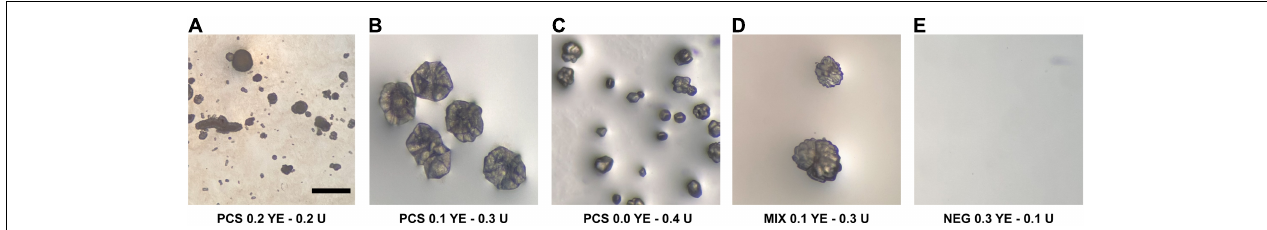
FIGURE 1 | Crystal-like formations observed in modified liquid B4 media inoculated with isolates from the soda straw and popcorn speleothems observed by a stereomicroscope. (A) PCS056 ( Sphingobacterium sp.) supplemented with 0.2% w/w yeast extract (YE) and 0.2% w/w urea (U). (B) PCS056 supplemented with 0.1% w/w YE and 0.3% w/w U. (C) PCS-56 supplemented with 0.0% w/w YE and 0.4% w/w U. (D) Mixed culture of SSS006 ( Sporosarcina sp.) and SSS035 ( Pseudarthrobacter sp.) supplemented with 0.1% w/w YE and 0.3% w/w U. (E) Negative control supplemented with 0.3% YE and 0.1% U. All micrographs under 40 ×